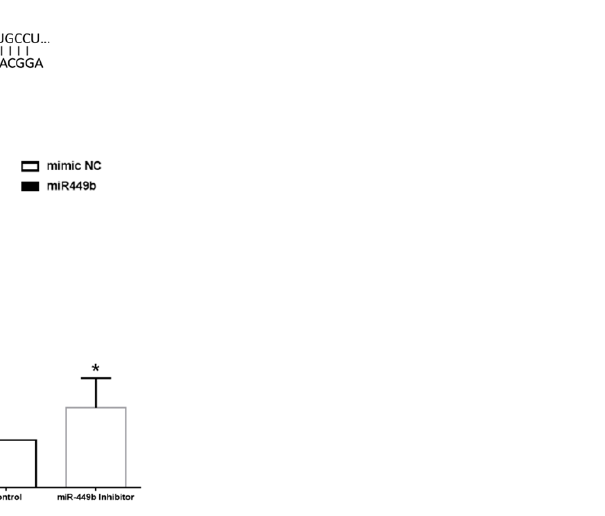
Figure 8. miR-449b targeted Notch1 and modulated the Notch1 level in cells. ( a , b ) H293T cells were co-transfected with either miR-449b mimic or scrambled control miRNA and a luciferase construct containing the Notch1-UTR (wild-type or mutant). After 48 h, cells were collected, and the dual luciferase assay was performed. ** p < 0.01 vs. negative control. ( c ) Western blot detection of Notch1 expression in NE-4C and showing the semi-quantitative results of protein expression in bar graph. N = 6 per group. * p < 0.05.